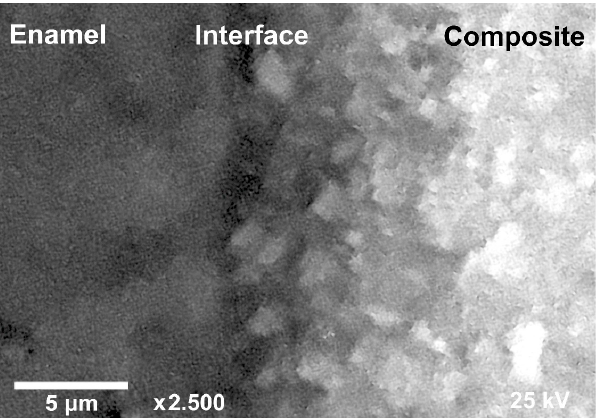
Int. J. Mol. Sci. 2022 , 23 , 11699 Figure 2. Typical SEM image of the enamel-dental composite heterointerface for the sample S I . Using the FTIR optical system of the Hyperion 3000 microscope, we selected, for fur- ther analysis, those portions of the interface within which no mechanical defects from pol- ishing or any other structural artifacts were visually observed. The analysis of the chemical composition as well as the molecular features of the samples in the enamel-biocomposite interface was performed using the FTIR technique. In contrast to a number of other methods of molecular composition analysis (e.g., Raman spectroscopy), when using the FTIR technique, samples of a biological nature are sub- jected to weak external influences when under study. Therefore, the information obtained refers to a system that has not undergone changes as a result of these interactions, and changes in the interface region caused by molecular transformations can be easily identi- fied. Figure 3 shows the representative FTIR spectra of substances (chemical components) present in the interface area of all samples, as well as the materials we used to create a hybrid interface. Thus, Figure 3 shows the absorption spectra in the infrared fingerprints region for the healthy enamel, DyractXP dental compomer material, the conditioner in- cluding the amino acid booster, bioprimer, calcium alkali, original and modified BisGMA- based adhesive, and the nanocrystalline carbonate-substituted calcium hydroxyapatite (HAp). For convenient analysis of the changes in the molecular spectrum of the condi- tioner and adhesive after their modification, Figure 3b,c presents the IR spectra in the re- gion of the most pronounced transformations of the vibrational modes.